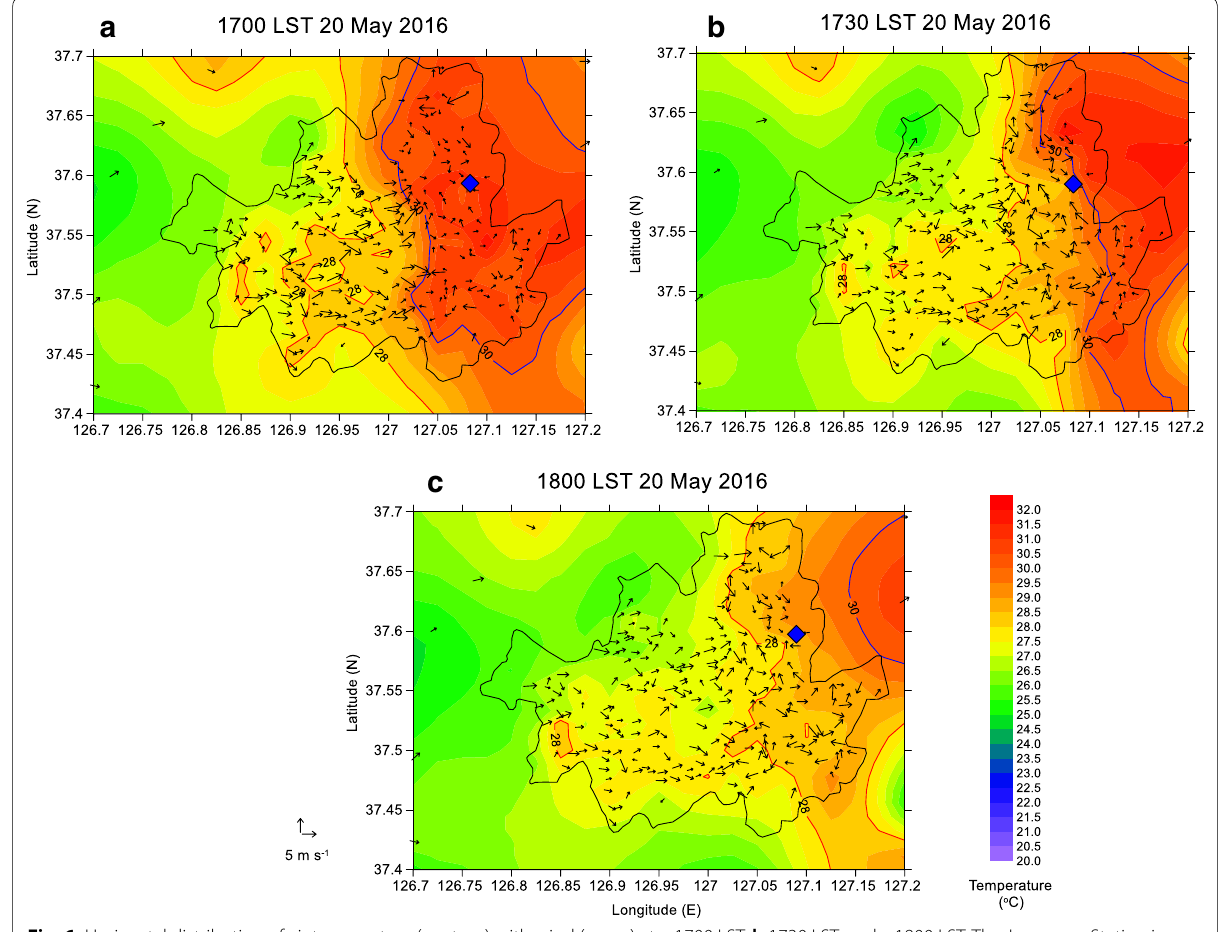
Fig. 6 Horizontal distribution of air temperature (contour) with wind (arrow) at a 1700 LST, b 1730 LST, and c 1800 LST. The Jungnang Station is indicated by the blue‑filled